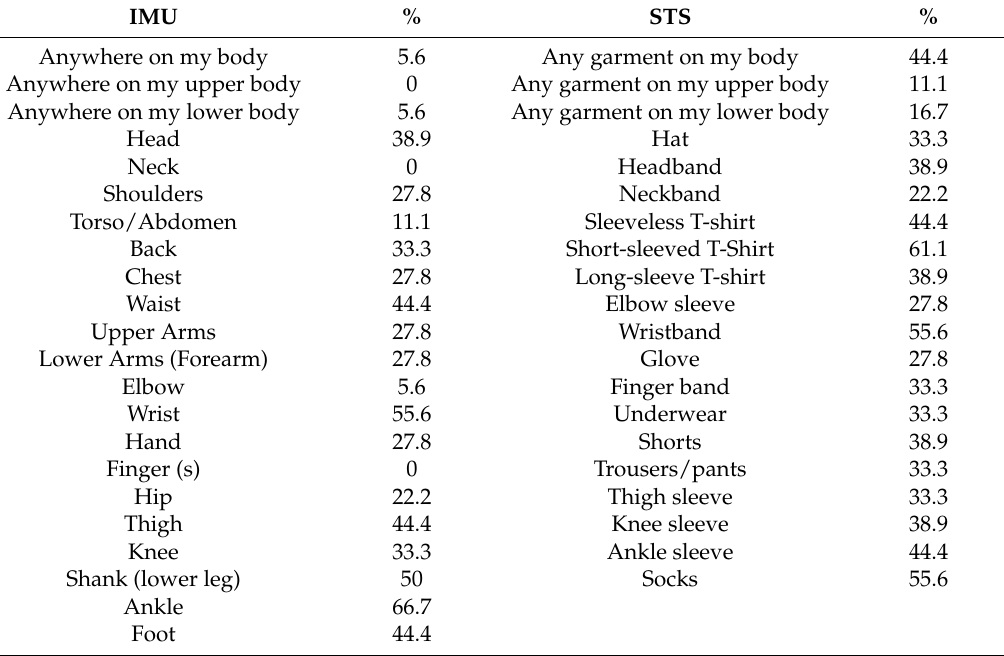
Table 4. Preferred placement of IMUs and preferred garment for an